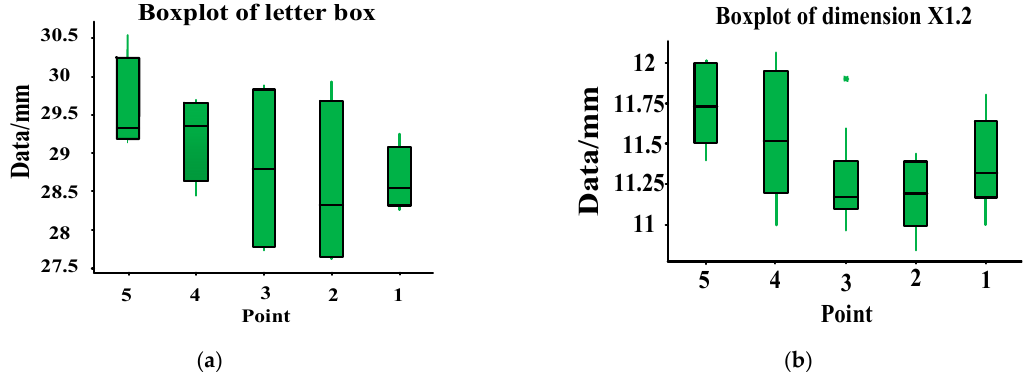
Figure 13. X1 size calculated by Minitab. ( a ) Dimension statistical chart of X1.1; ( b ) dimension statistical chart of X1.2. Fifty percent of the points fall in the green area, the black line in the green area represents the average value, and 20% of the points fall in the upper and lower green solid lines respectively.